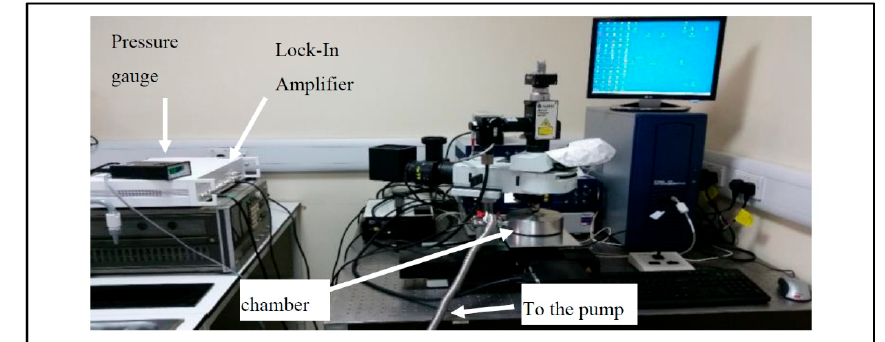
Figure 2. Vibrometer test station arrangement.